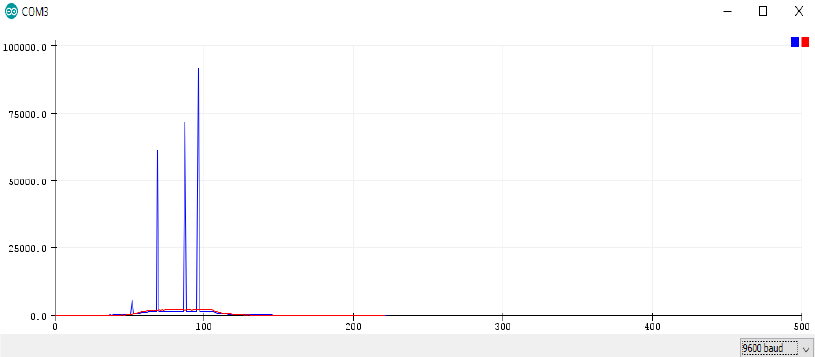
Figure 9. The output of the Serial Plotter during false software-generated spikes.